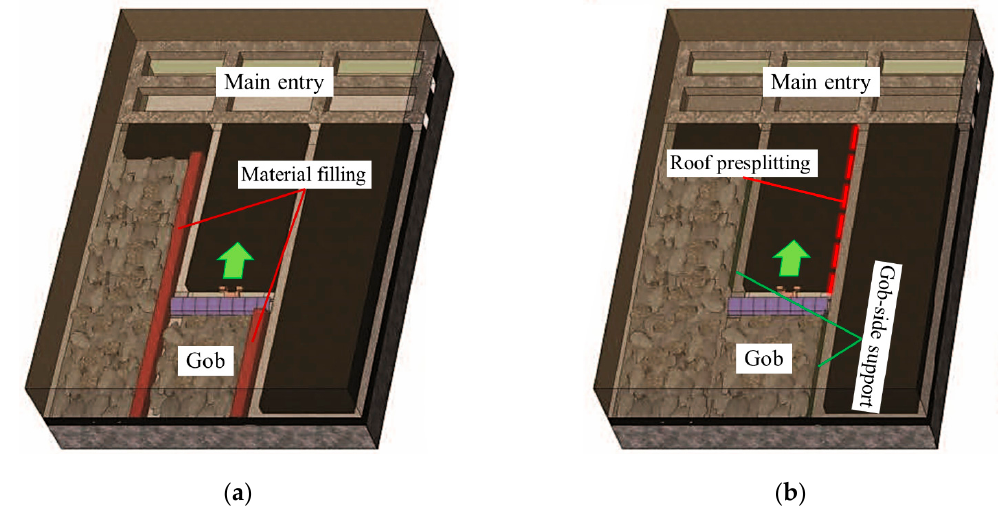
Figure 2. Different GER approach. ( a ) Material filling; ( b ) roof presplitting. Figure 2. Di ff erent GER approach. ( a ) Material filling; ( b ) roof